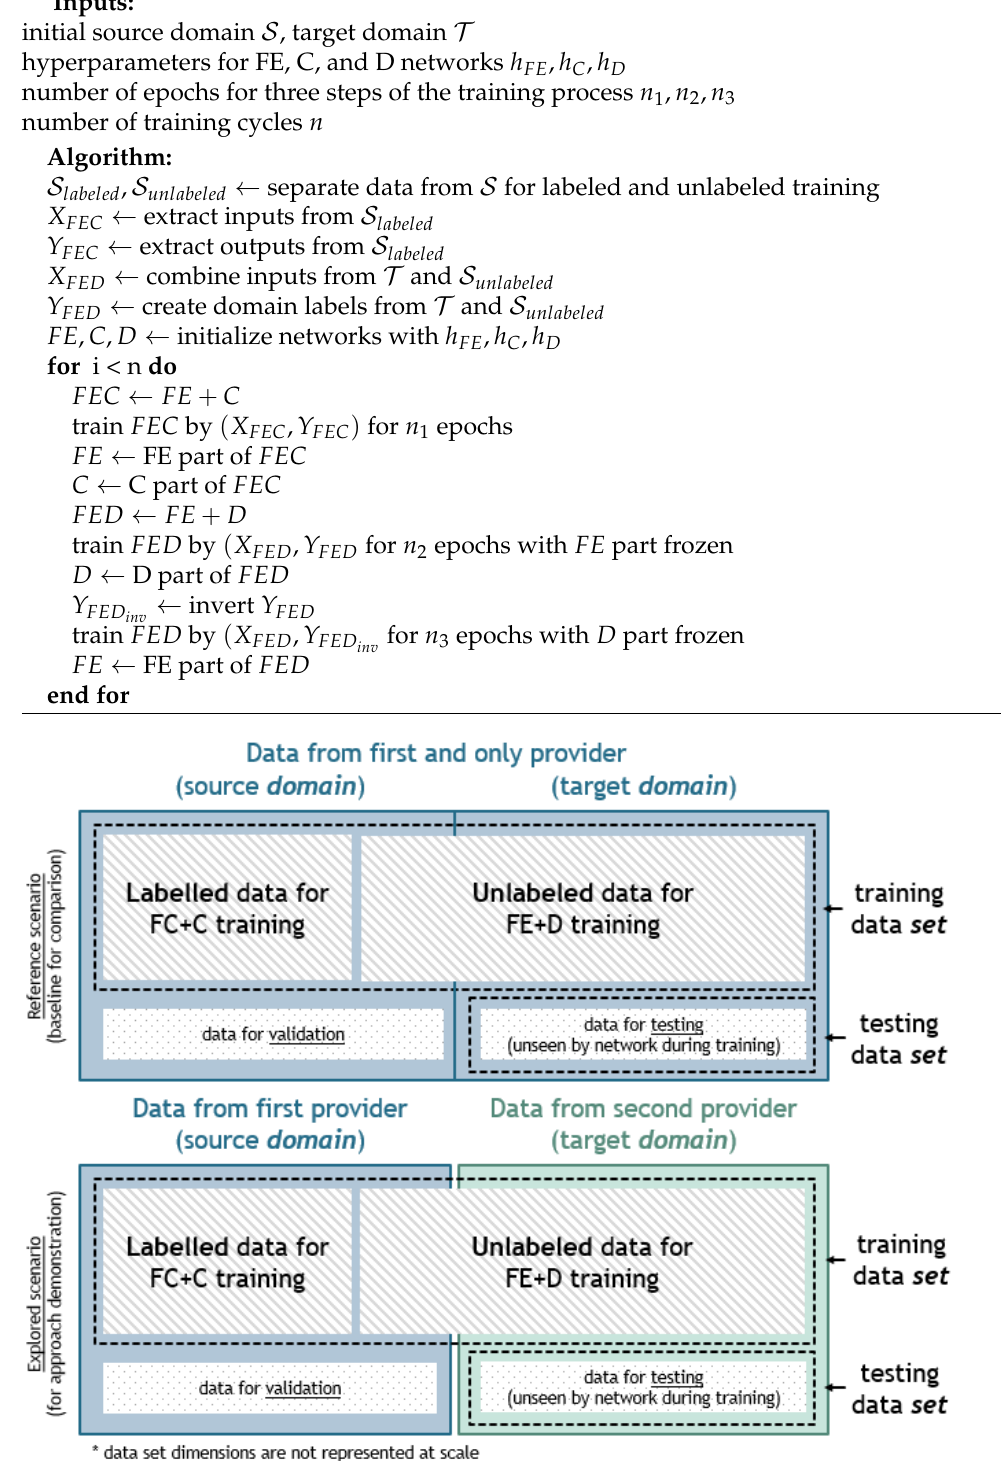
Figure 3. Domain vs.